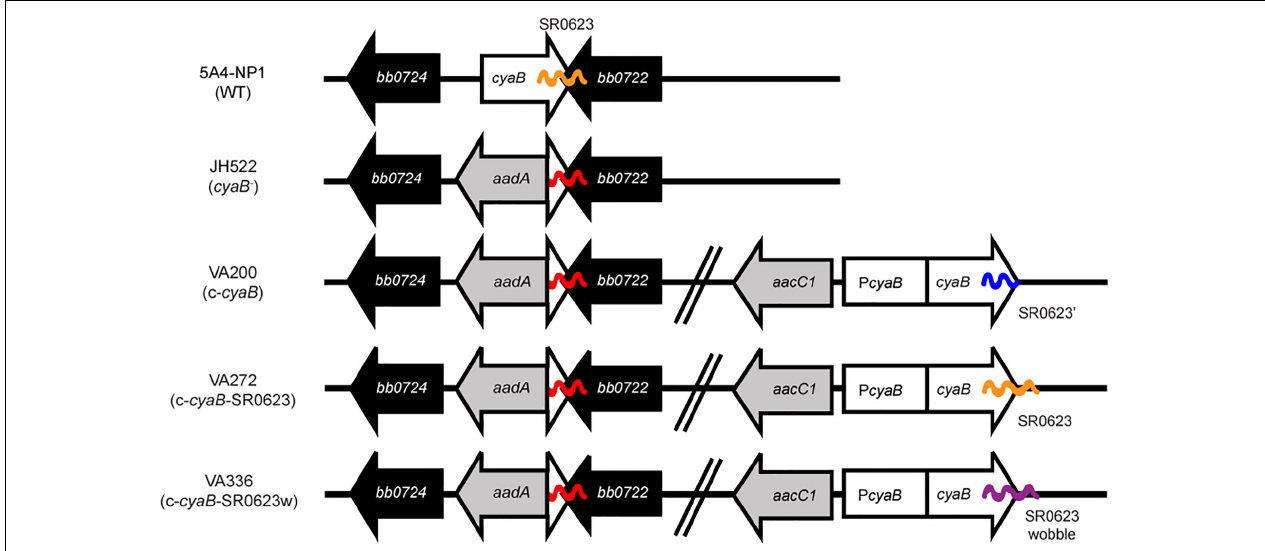
FIGURE 1 | Schematic of the cyaB mutant and trans -complement strains. The cyaB deletion strain JH522 was generated through the insertion of an aadA antibiotic cassette to disrupt cyaB ( bb0723 ) while keeping bb0722 intact. Chromosomal cyaB complementation strains were made through the introduction of an aacC1 antibiotic cassette. Complement strain VA200 contains the cyaB open reading frame (ORF) while truncating the sRNA SR0623, strain VA272 contains both the cyaB ORF and SR0623, and strain VA336 contains the cyaB ORF and a wobble mutation of SR0623. ORFs are indicated by arrows and sRNAs by wavy lines.